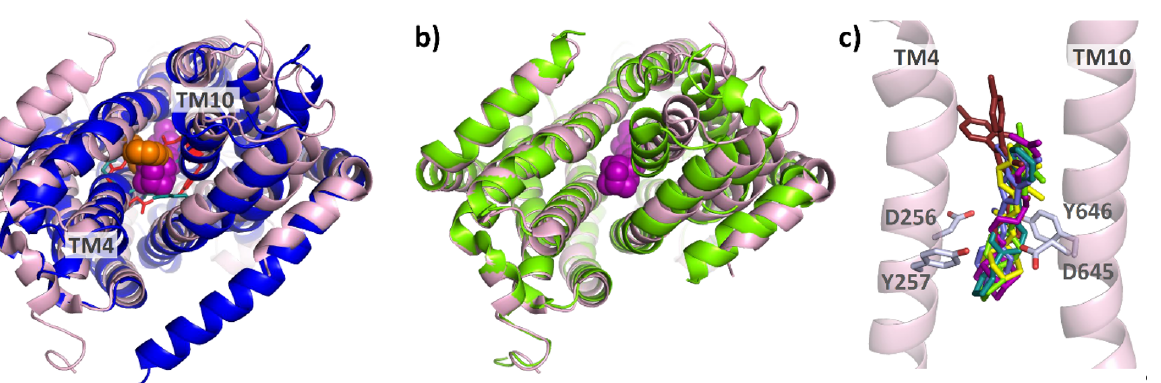
Figure 15. BDM88855-bound intermediate in comparison to the native AcrB L and T state. Cartoon models of the BDM88855 (shown as orange spheres) bound L-state (7OUK) and the native L and T states of AcrB (both 4DX5) were overlayed via their FD domains (residues 181–272 and 724–812). As can be seen, the entire periplasmic domain of AcrB/BDM88855 (blue) remains in the native L state (light blue) ( a ), while there are significant changes in the TMD ( b ). These changes are particularly evident in shifts of the second (right) TMD repeat (helices 7–12), which increases the cytoplasmic pocket. The conformation of the second repeat in the inhibitor-bound structure most closely resembles that of the native T state shown in yellow ( c ).